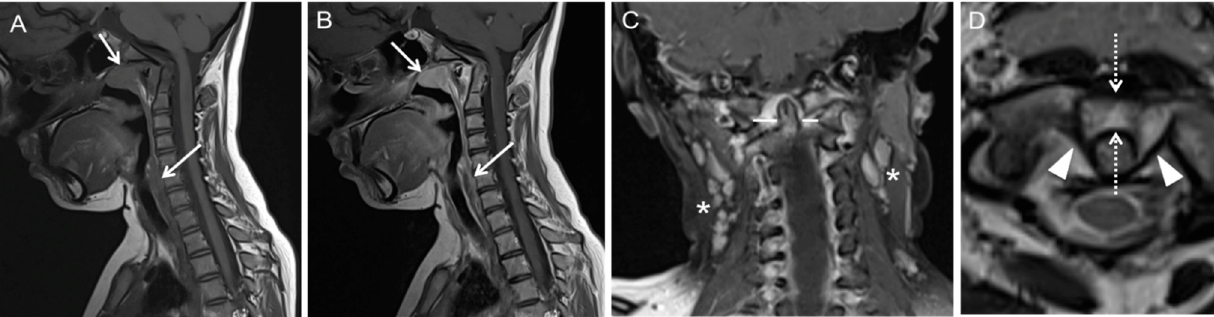
Figure 2. MRI shows edematous swelling and contrast enhancement of the posterior naso-, oro- and hypopharyngeal soft tissue ( A , B ); arrows; 2D T1w TSE pre and post CA. No abscess formation present. Enlarged cervical lymphnodes ( C ); asterisks; 2D T1w TSE post CA. Increased anterior atlantodental interval ( D ); dotted arrows; 2D T2w TSE. Asymmetry of odontoid lateral mass interval at midlateral mass level ( C ); line. Laxity of the transverse ligament of atlas ( D ); arrowheads. No spinal cord compression. T2w = T2-weighted; TSE = turbo spin echo; T1w = T1-weighted; CA = contrast